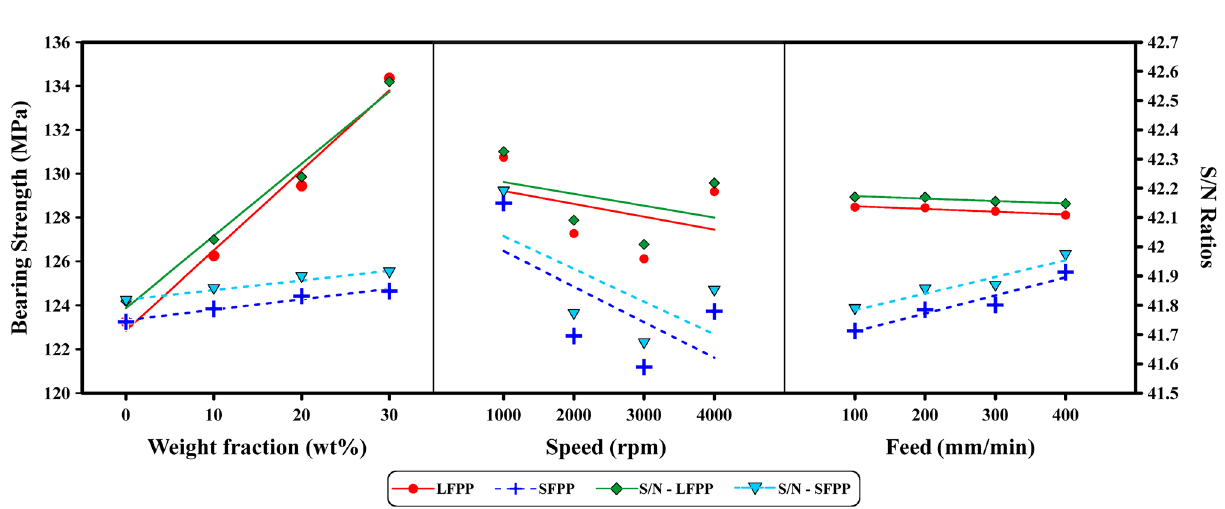
Figure 7. Mean effect plot for LFPP and SFPP for BS and S/N